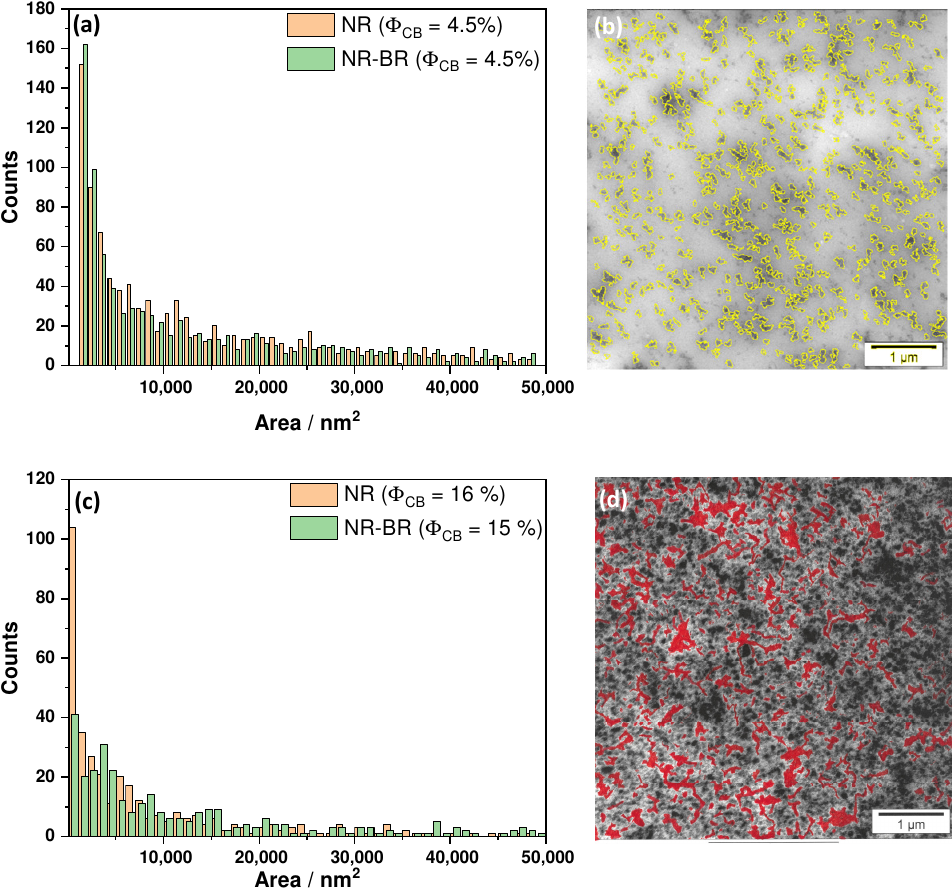
Figure 6. Histograms showing ( a ) the cluster size distribution for NR and NR-BR samples filled with 4.5 vol.% carbon black and the ( c ) size distribution of unfilled areas for NR and NR-BR composites containing Φ CB 16 or 15 vol.%, respectively. In the TEM images, the identified filler clusters and the unfilled regions are highlighted by color for NR composites containing ( b ) 4.5 vol.% CB and ( d ) 16 vol.% CB,